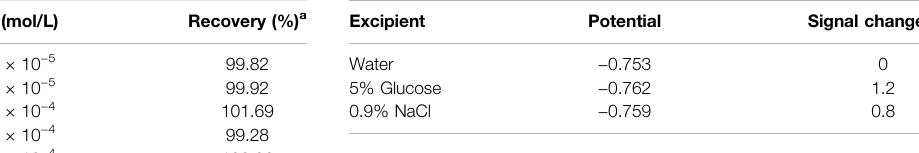
TABLE 2 | Recovery of paclitaxel. TABLE 3 | Effect of excipients on potential in 1.0 × 10 − 4 M